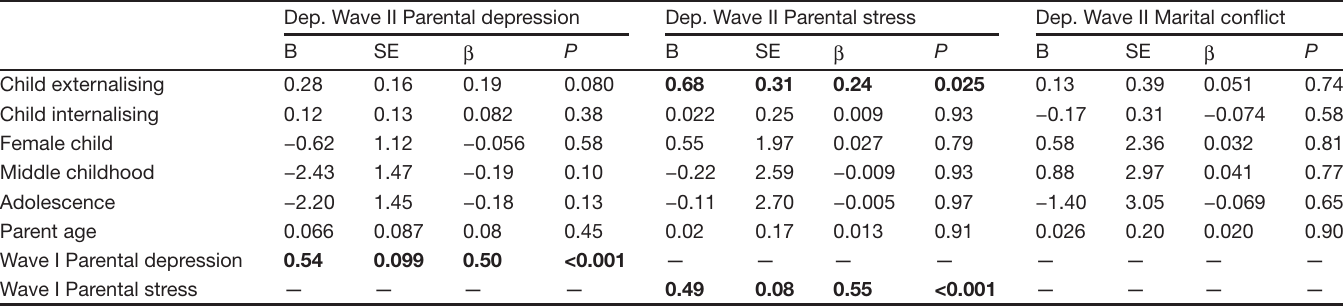
Table 4. OLS regression models Dep. Wave II Parental depression Dep. Wave II Parental